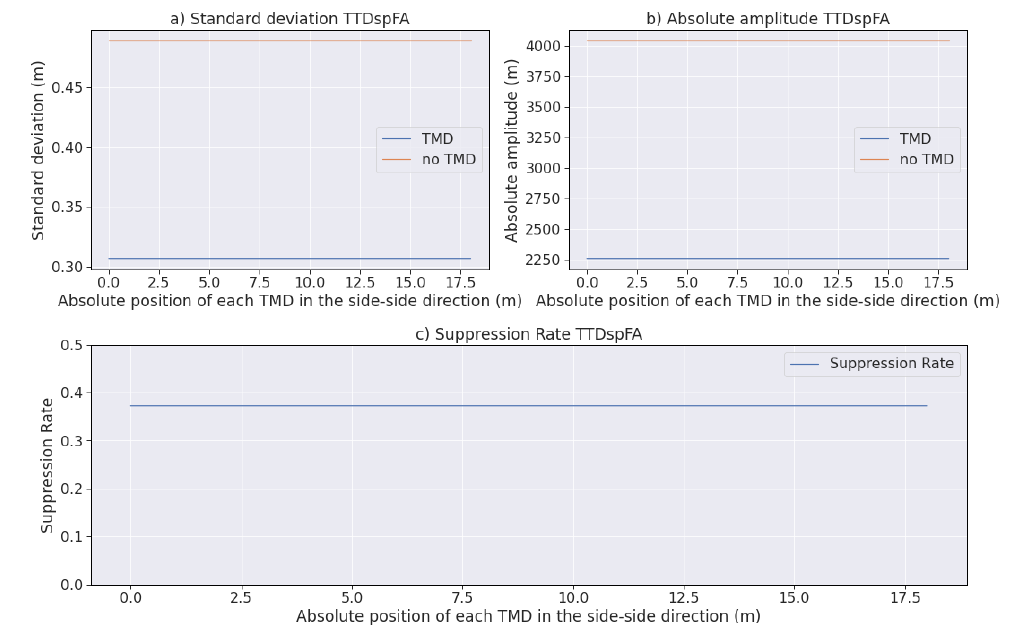
Figure 12. The results when moving two TMDs in the side-side direction keeping the same distance to the center. ( a ) Sum of TTDspFA standard deviation; ( b ) Sum of TTDspFA amplitude; and, ( c ) TTDspFA suppression rate.